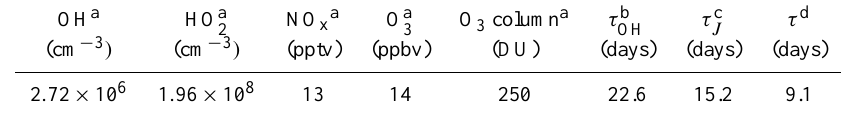
Table 2. Concentration and lifetime of important species for the organic bromine chemistry in the BG simulation at 1km.